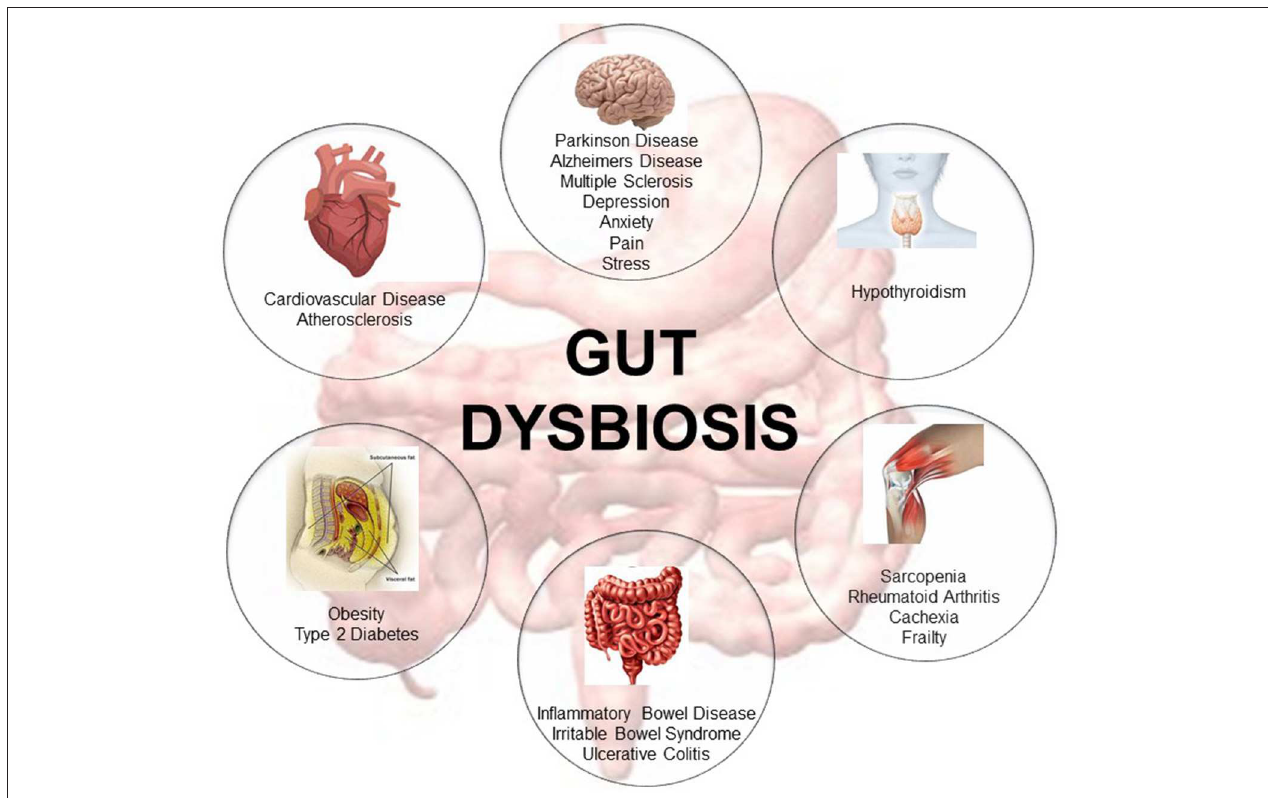
FIGURE 1 | Representative description of the metabolic diseases, gastrointestinal disorders, neuromusculoskeletal conditions, endocrine pathologies, neurodegenerative, and cardiovascular diseases associated with gut dysbiosis [adapted from Buford (